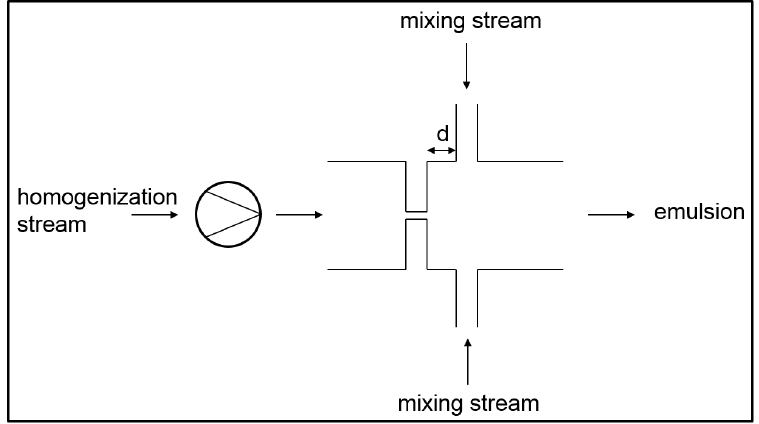
Figure 3. Function principle of SEM process.